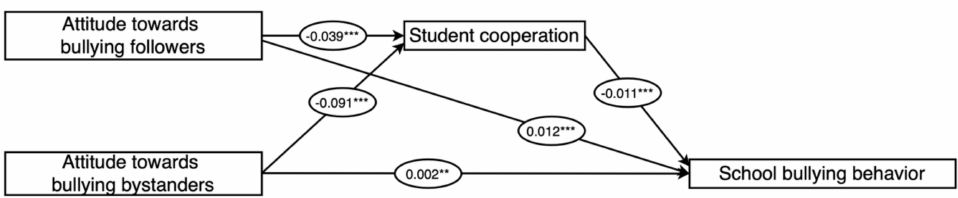
Figure 2. The effect pathways of adolescent bullying attitudes on school bullying behavior. ** p > 0.01, *** p >